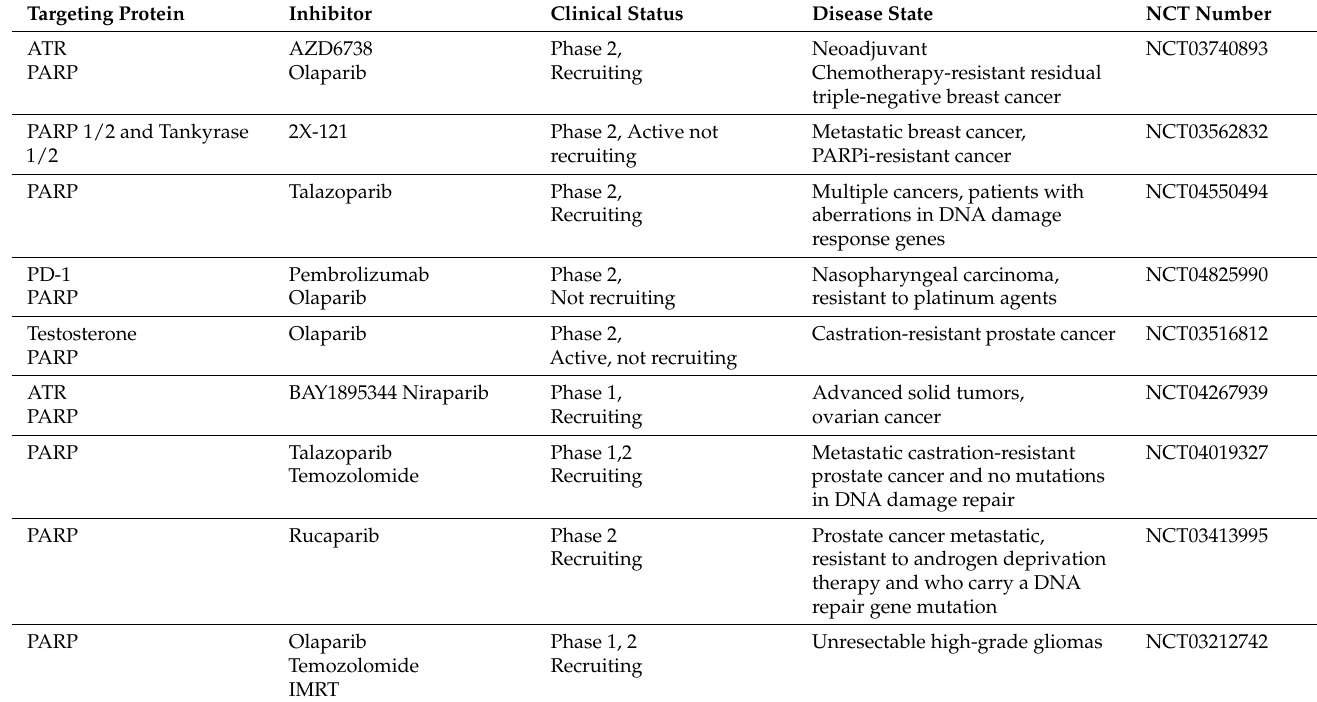
Table 2. DNA repair pathway inhibitors currently in clinical trials to sensitize cells to